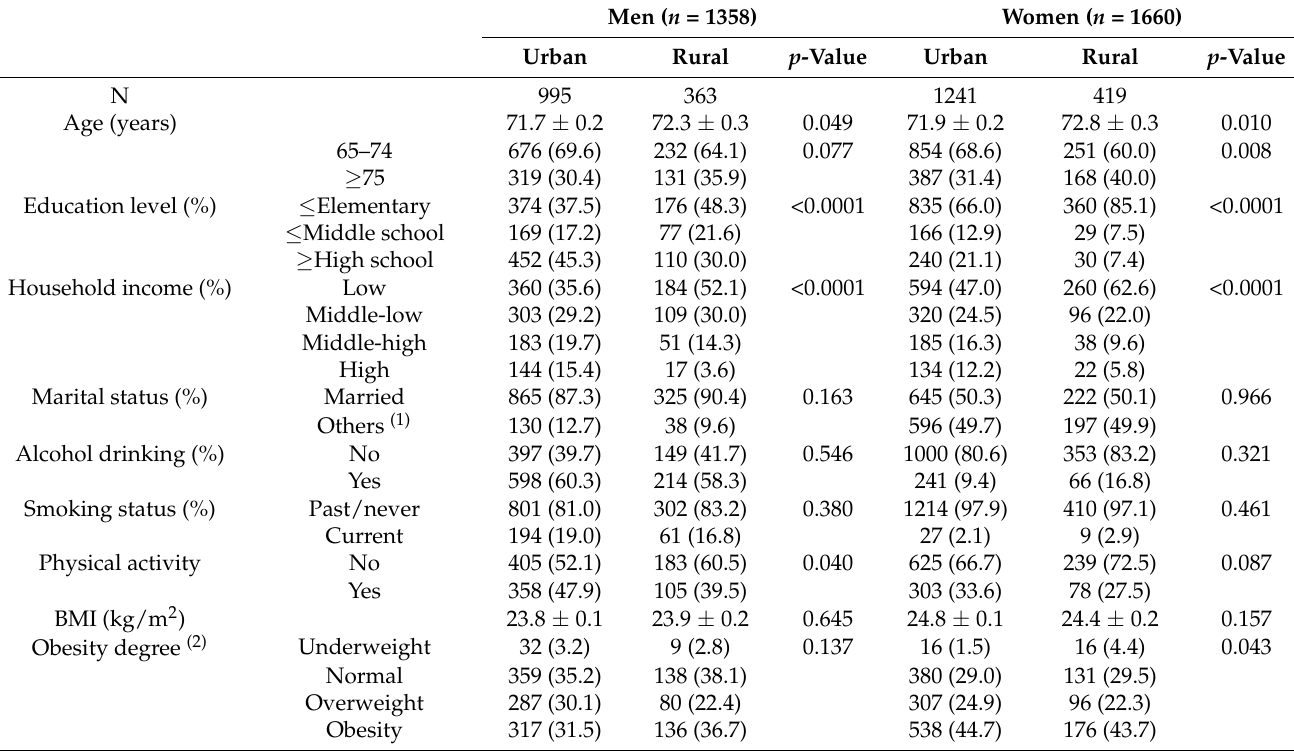
Table 1. Socio-demographic factors of subjects. Men ( n = 1358) Women ( n =